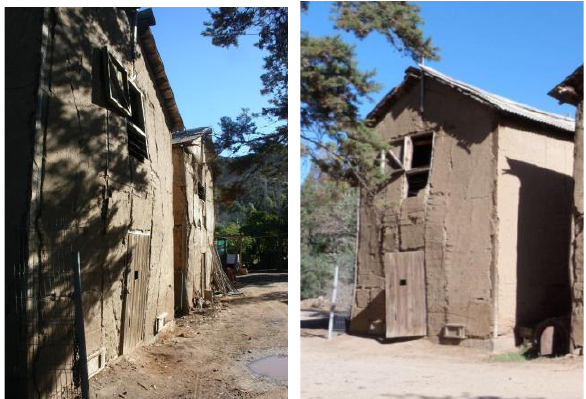
Figure 10. Severe deformation of a tabique wall associated